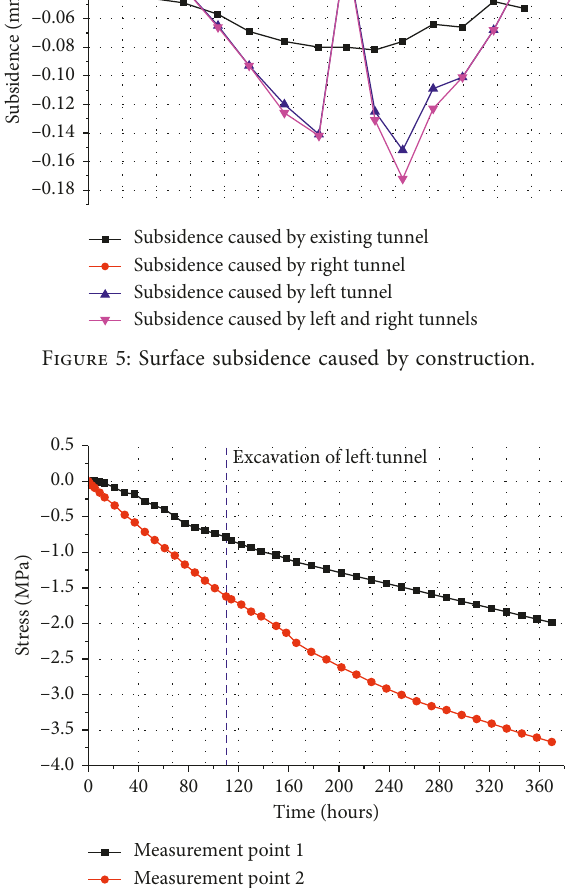
Figure 6: Time history curve of the surrounding rock stress below the toe of the middle partition wall.